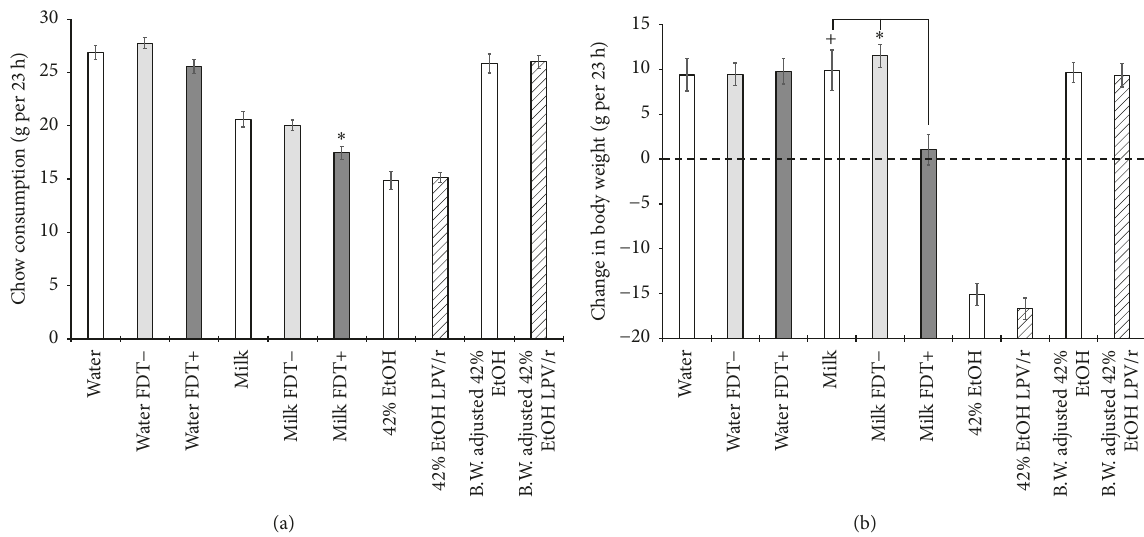
Figure 4: Solid food consumption (a) and changes in body weight (b) during the 23-h solution test sessions. Star ( 𝑝 < .01 ) and plus ( 𝑝 < .05 ) symbols represent significant decreases for the FDT+ compared with control solutions.